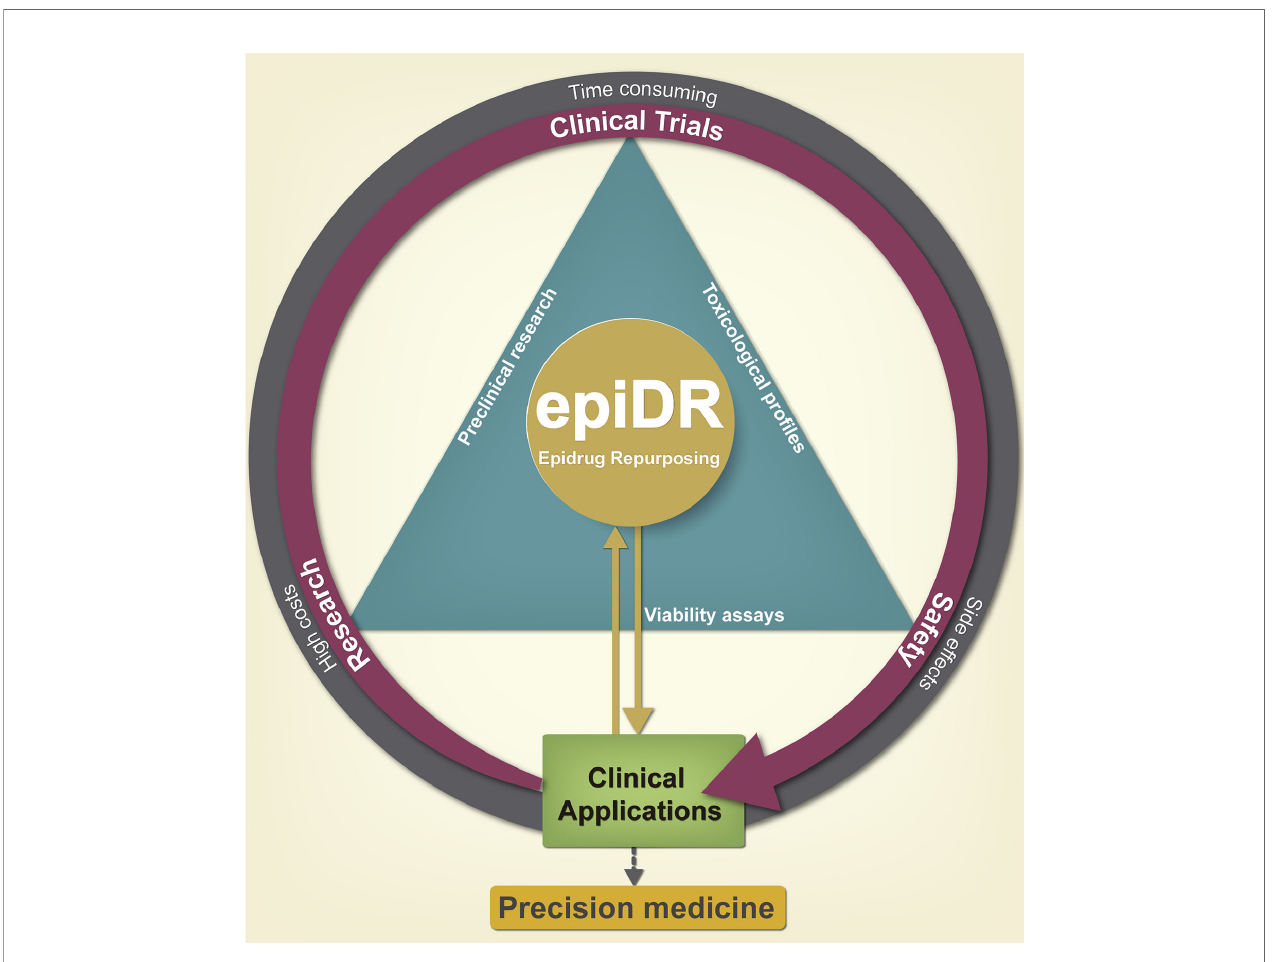
FIGURE 4 | Advantages of pharmacological epi-drug repurposing in clinical applications. Drug repurposing serves as a shortcut reducing the time of incorporating a drug into the clinic; since the preclinical phase has already been carried out previously, giving a second chance to old drugs. Initially, it reduces the cost of development and toxicity research, which leads to greater cost-bene fi t ef fi ciency for the pharmaceutical industry by generating a new cancer therapy. The repositioning of epi-drugs is a promise for the generation of new drugs of precision